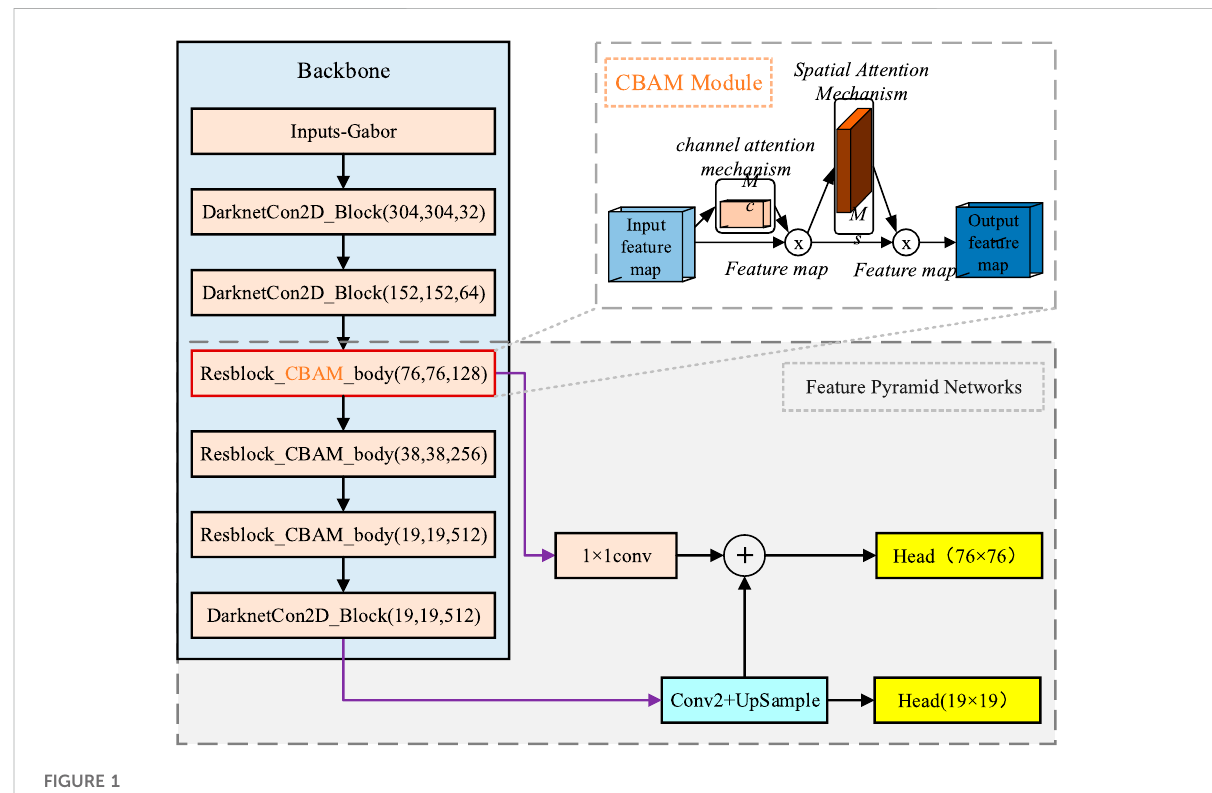
FIGURE 1 Structure of the